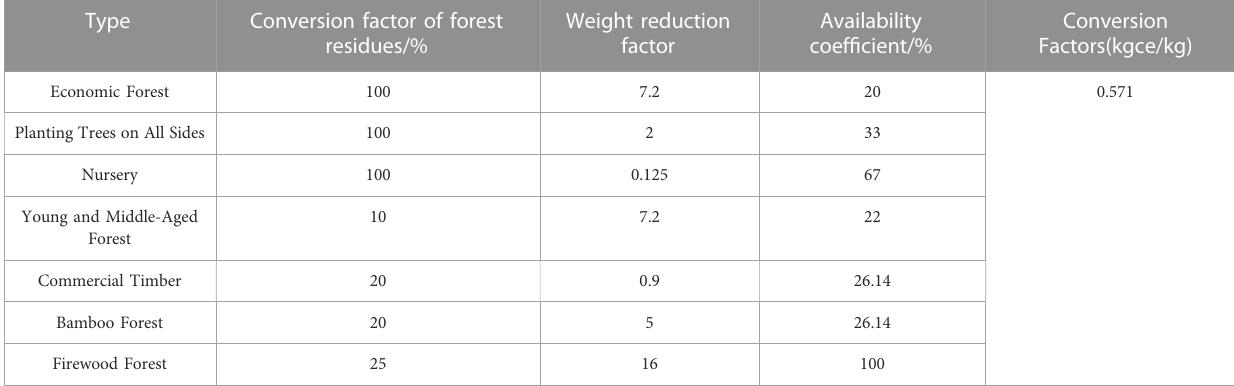
TABLE 5 Conversion factor, weight reduction factor, availability coef fi cient and conversion factor of forest residues.